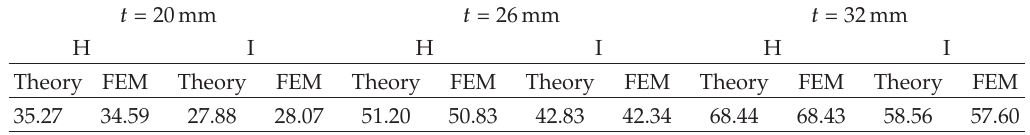
Table 1: Collapse pressures (cid:3) MPa (cid:4) for homogeneous rings (cid:6) H (cid:7) and lower bound pressures (cid:3) MPa (cid:4) for inhomogeneous rings (cid:6) I (cid:7) (cid:6) D (cid:8) 457 . 2mm, ω (cid:8) 1 / 1000, n (cid:8) 3, and θ c (cid:8) π/ 4 (cid:7) .